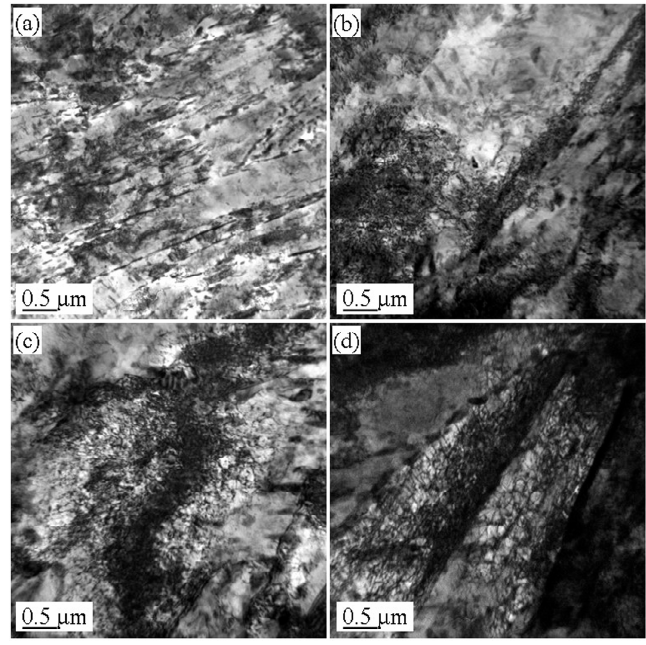
Figure 5. Microstructure of tempered 5140 steel tempered at 520 °C before and after different accumulated proton irradiation observed by TEM pictures of ( a ) 0 protons/cm 2 , ( b ) 2 × 10 14 protons/cm 2 , ( c ) 2 × 10 15 protons/cm 2 , ( d ) 2 × 10 16 protons/cm 2 .